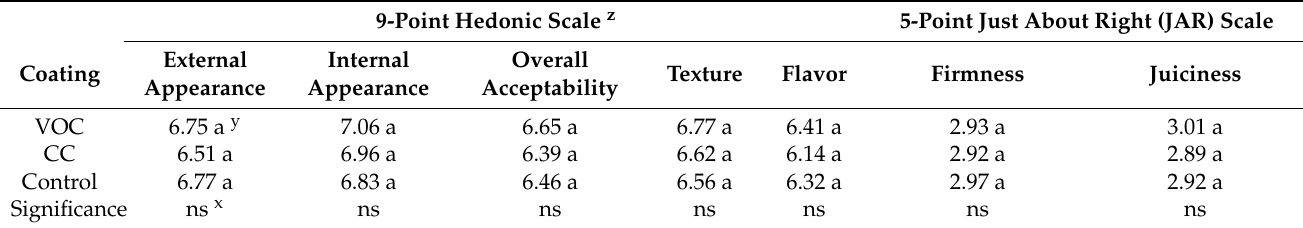
from ANOVA. Table 4. Sensory panel results for appearance, overall acceptability, texture, and flavor (9-point hedonic scale) and firmness and juiciness (5-point Just About Right Scale) of coated and uncoated pitaya fruit after 15 days storage at 7 ◦